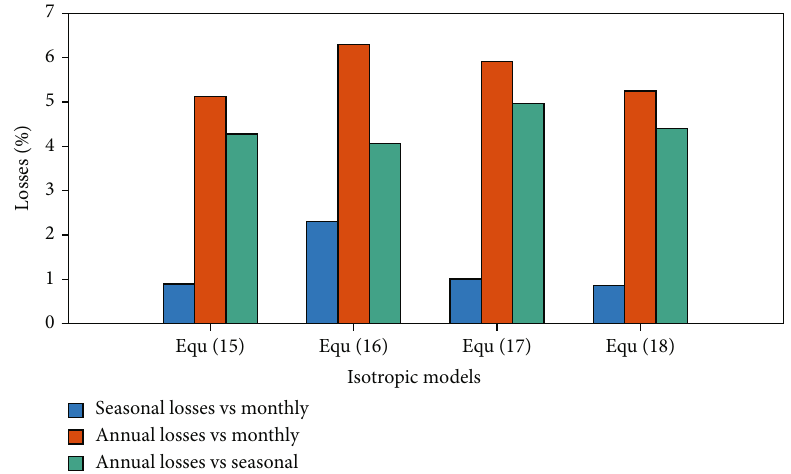
Figure 10: Solar radiation seasonal losses, annual losses relative to monthly and annual losses relative to seasonal